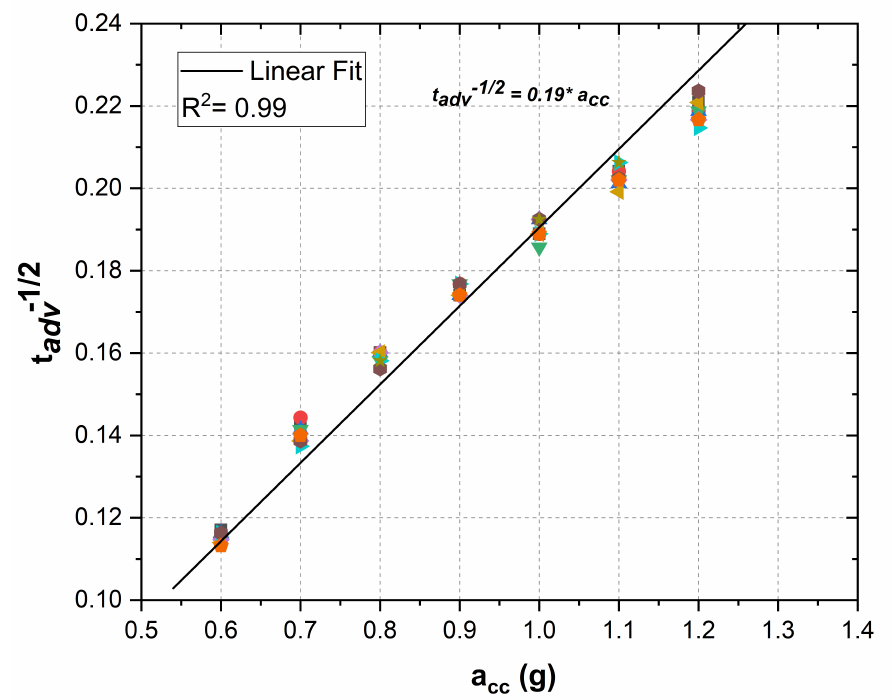
Figure 9. Linear fit of the experimental measurement data for various accelerations from 0.6 g to 1.2